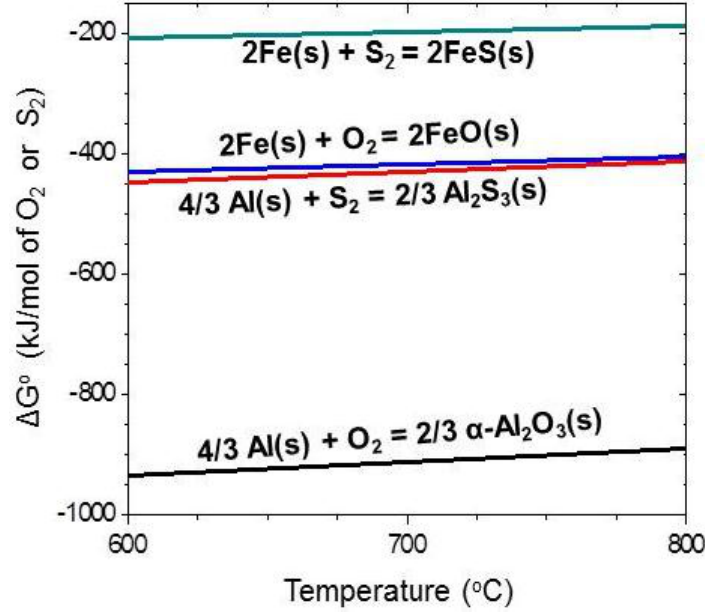
Figure 6. Ellingham diagram of oxides and sulfides that can form on the Al hot-dipped steel.